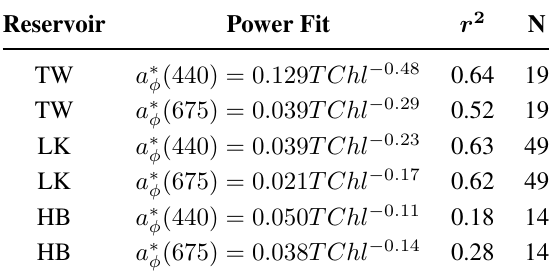
and TChl at selected wavelengths for each reservoir. φ